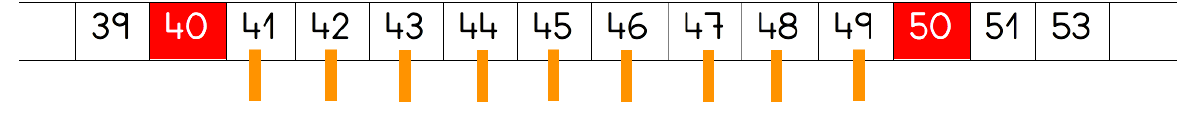
Figure 11. Other family number highlighted.